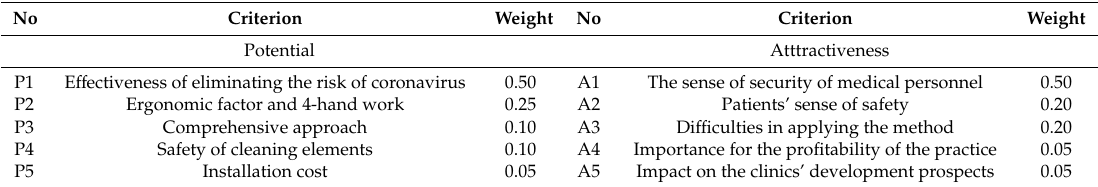
Table 1. Criteria for comparative evaluation of groups of methods of protection against the e ff ects of SARS-CoV-2 coronavirus.